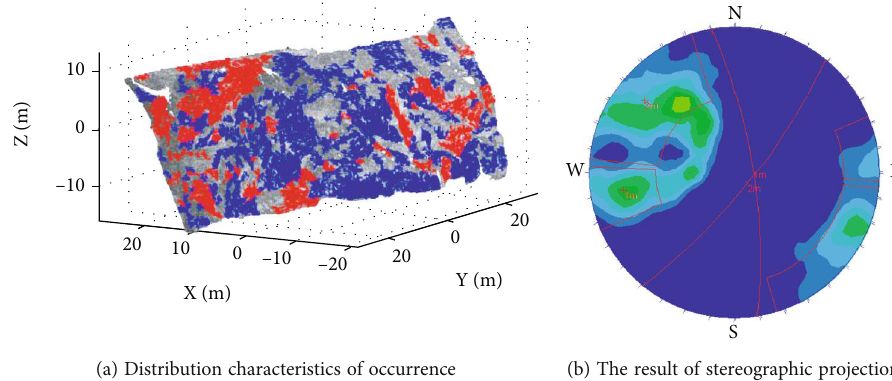
Figure 7: Occurrence distribution characteristics of the rock mass structural plane after clustering and the result of stereographic